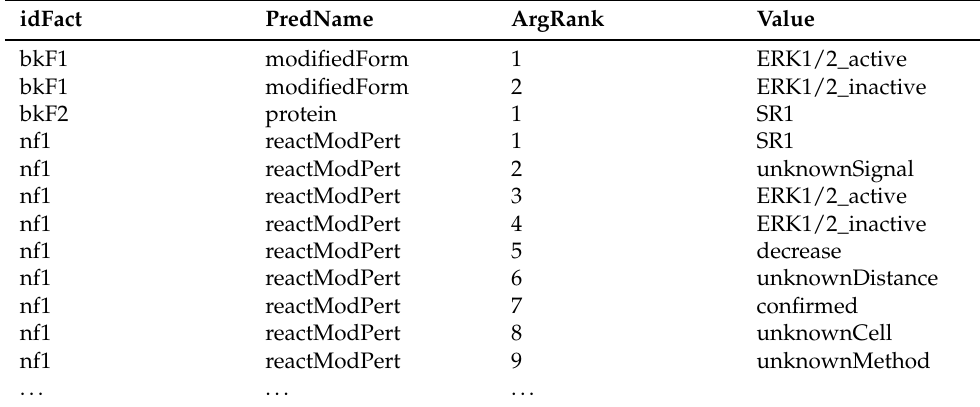
Table 10. The ArgValuesFacts table.